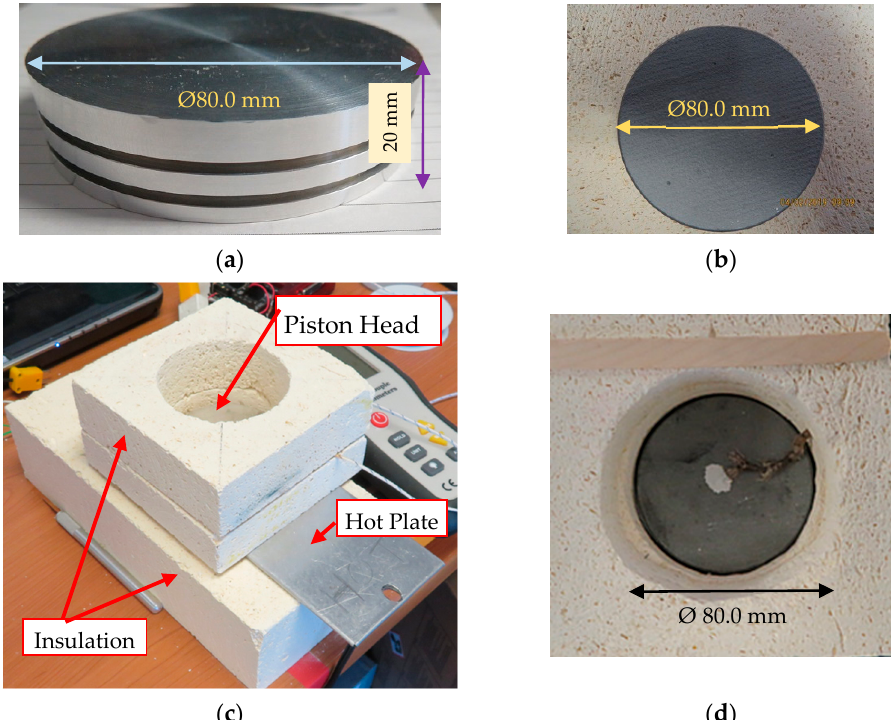
Figure 4. Experiments on piston head model: ( a ) piston model without coating; ( b ) piston model with multilayer coating; ( c ) experimental setup used to test the thermal properties of TBCs on piston head model; ( d ) piston model with thermocouple attached to the top coating.